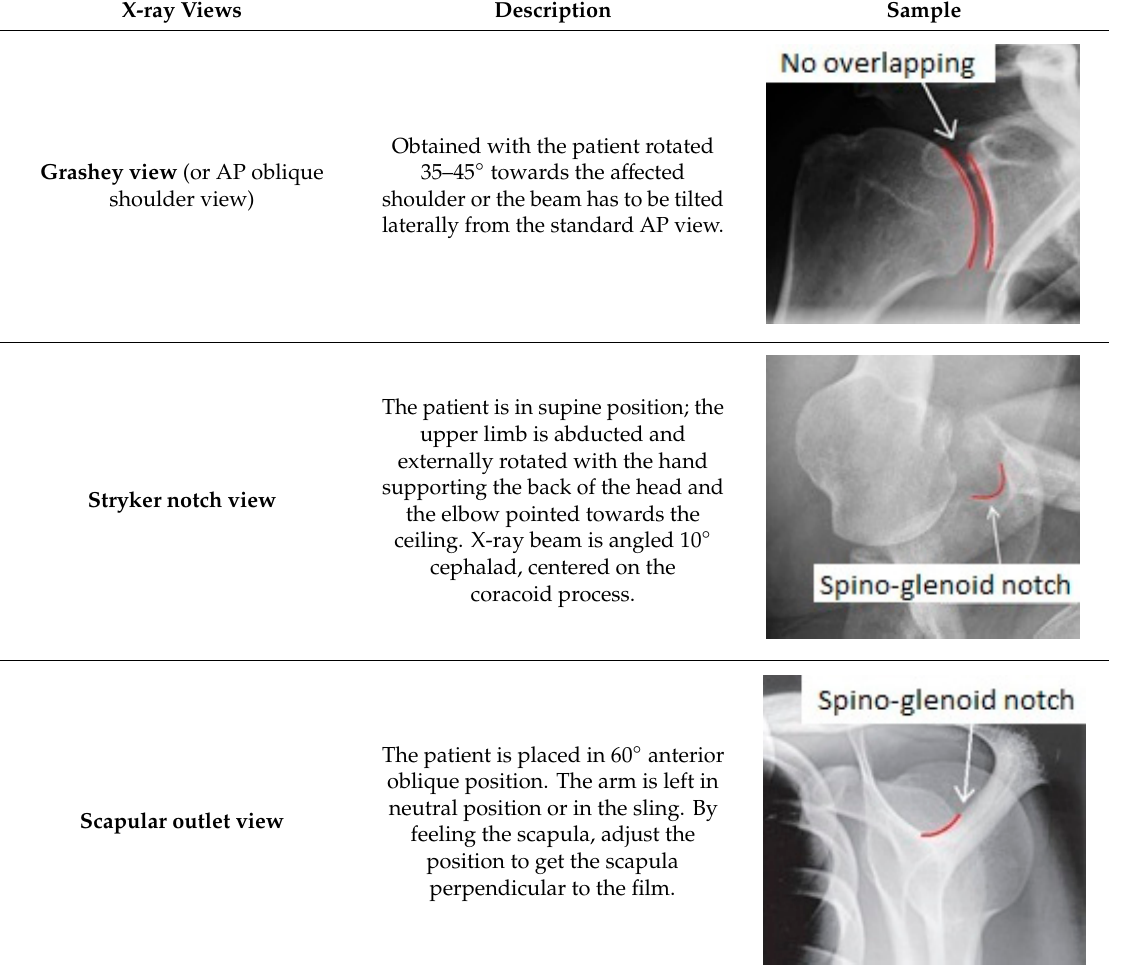
Table 2. Name, description and sample of the main specific x-ray views.